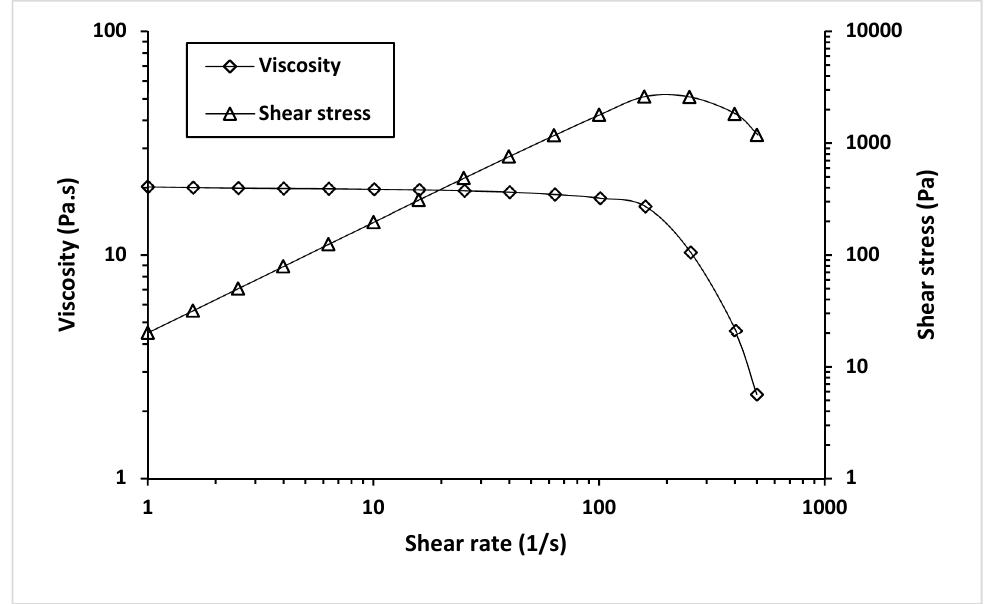
Figure 11. Viscosity and shear stress profiles relative to a shear rate of MCL-PHA biomaterial-ink are rheologically tested at 130 °C.